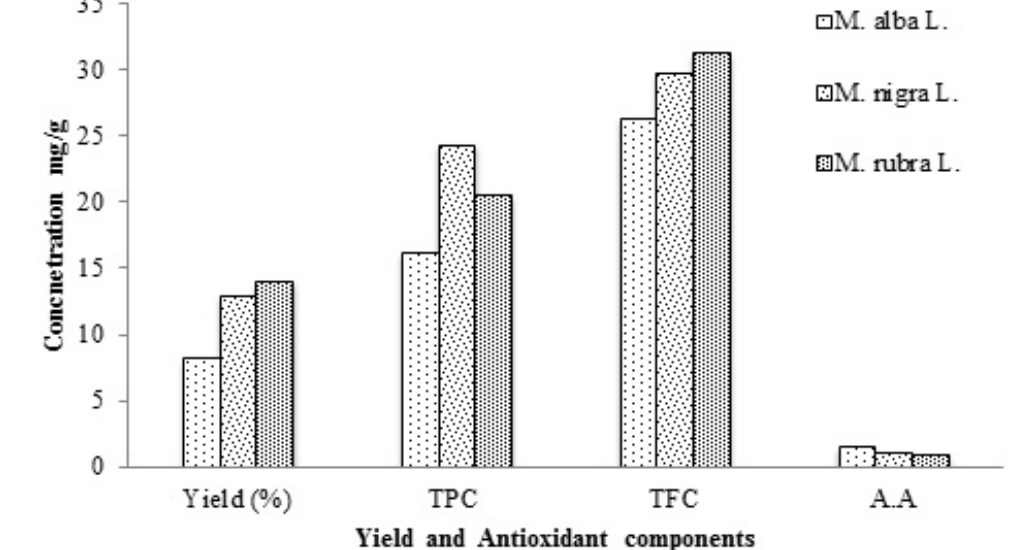
Figure 1. Yield and contents of Phenolics, Flavonoids and Ascorbic acid in extracts from dried leaves of three mulberry varieties ( p <